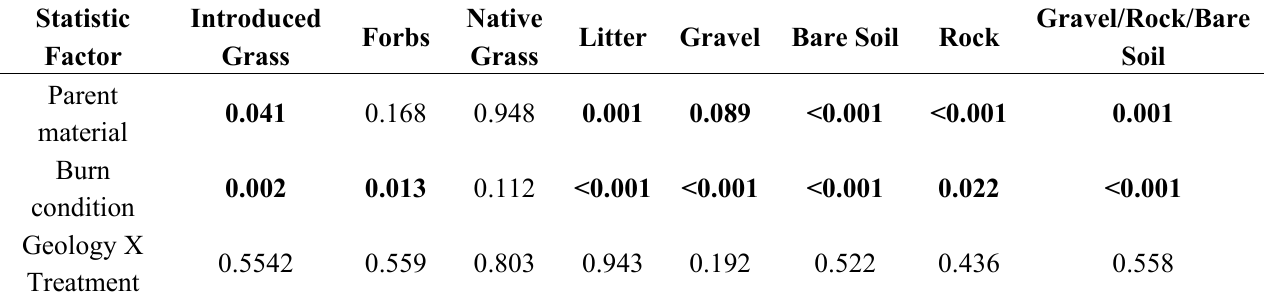
Table 5. Two factor analysis of variance comparison using parent material and burned/unburned treatment. The bold values are significant at α = 0.10.